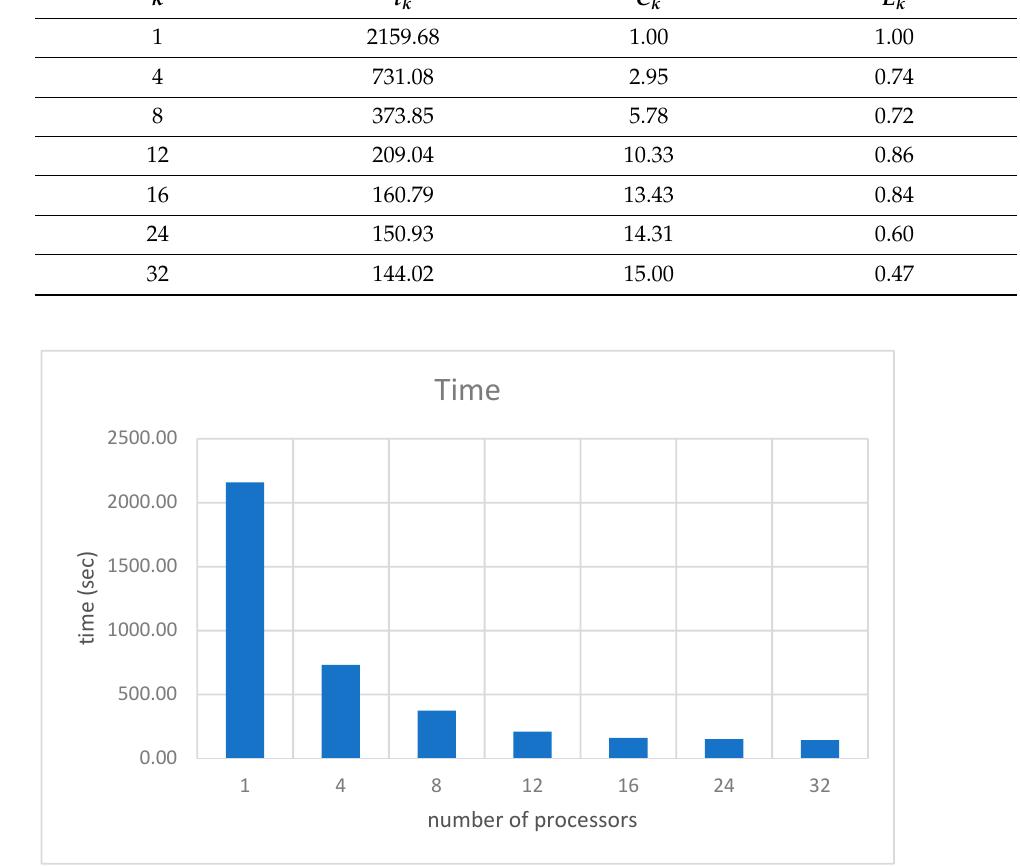
Figure 1. Diagram of solution time/number of processors.